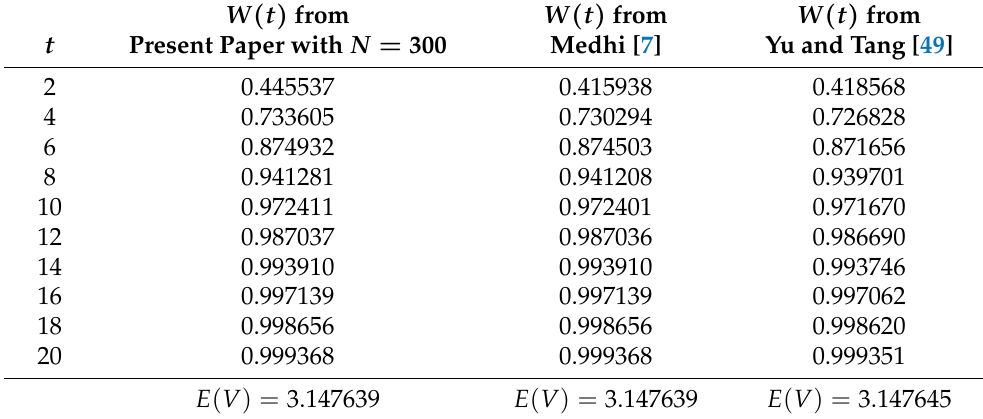
Table 8. Comparison among the CDF of sojourn times from Example 7 with the parameters λ = 3, µ = 1.0, a = b = 4, N = 300 and ρ =